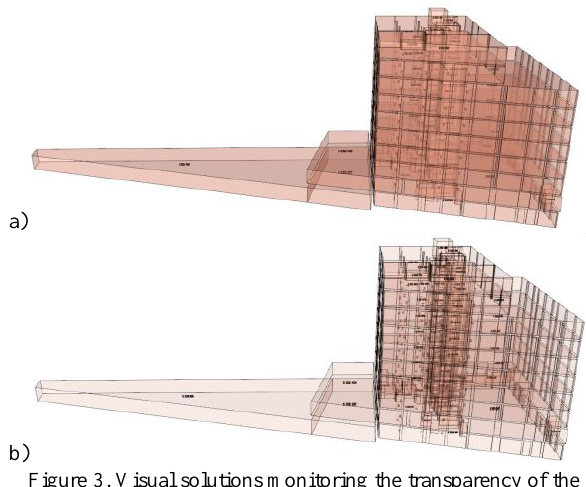
Figure 3. Visual solutions monitoring the transparency of the volume a- 70% and b-